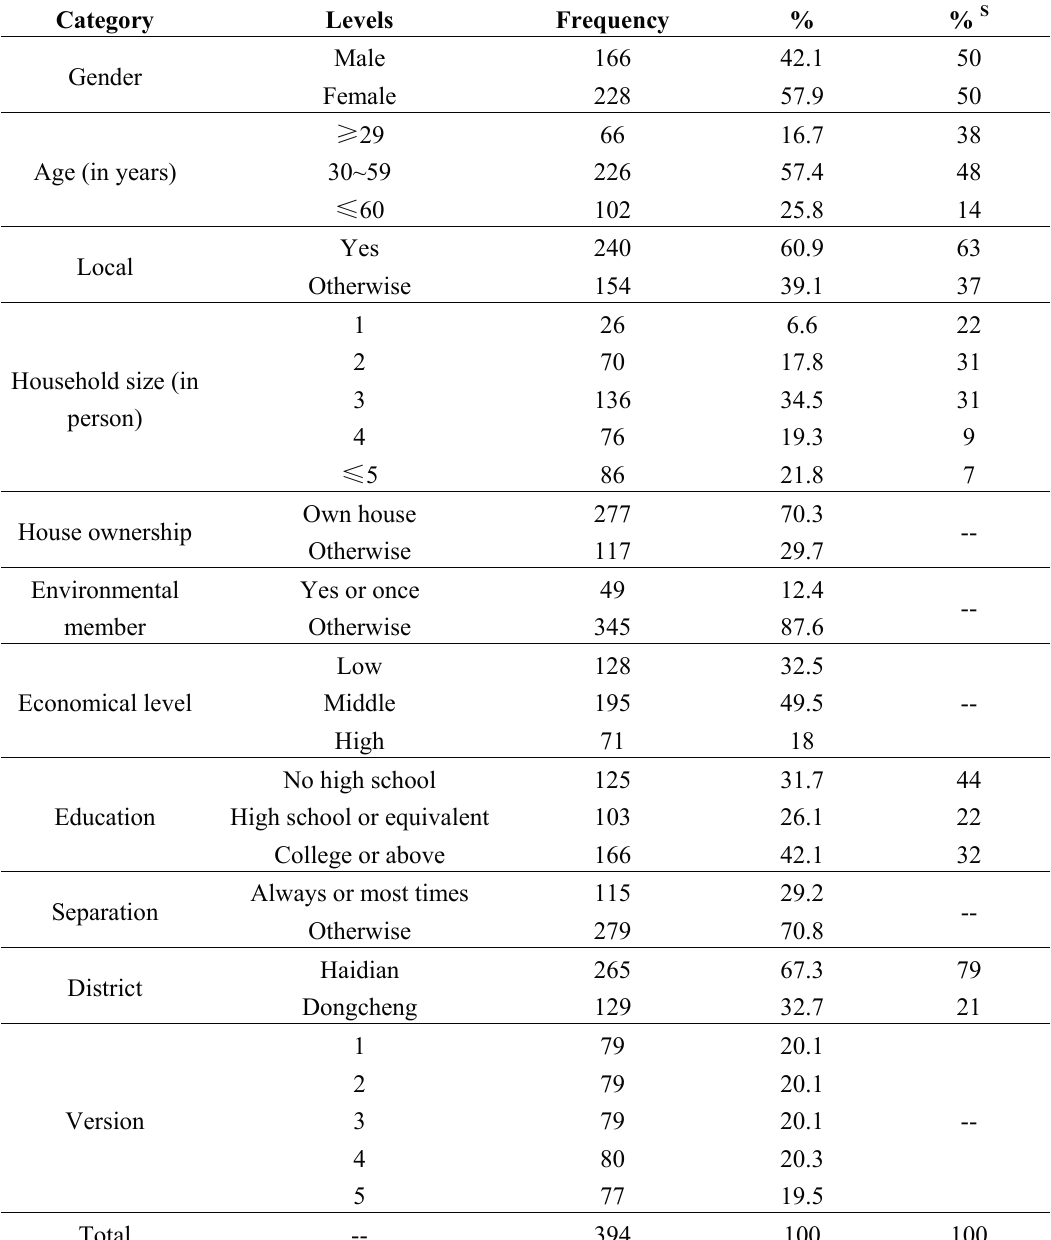
Table 2. Socioeconomic characteristics of the sample and